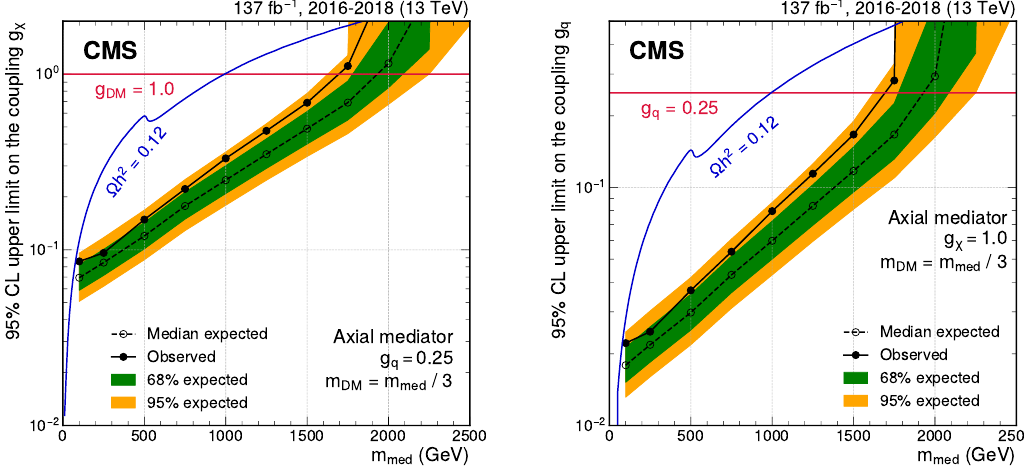
(left) and g (right) for an axial-vector Figure 8 . Exclusion limits at 95% CL on the couplings g χ q mediator. In each panel, the result is shown as a function of the mediator mass m , with the med mass of the DM candidate fixed to m = m / 3 . In either case, only one coupling is varied, DM med while the other coupling is fixed at its default value ( g = 0 . 25 or g = 1 . 0 ). The blue solid line q χ indicates the parameter combinations for which the simplified model reproduces the observed DM relic density. Around m , corresponding to m ≈ m ≈ 500 GeV, DM annihilation into top DM top med quarks becomes possible, leading to a shift in the relic density. The corresponding results for a vector mediator are shown in figure 20 in appendix A.4.